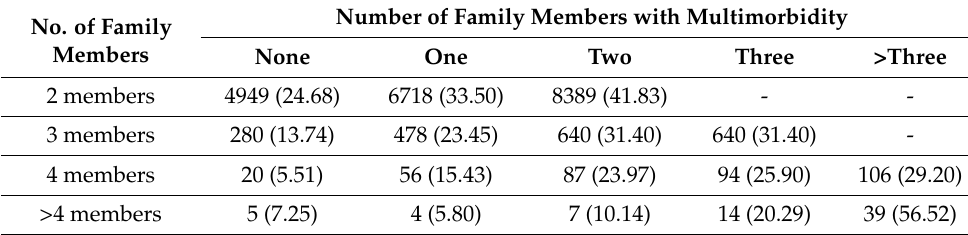
Table 2. Proportion of multimorbidity at the family level ( n = 22,526